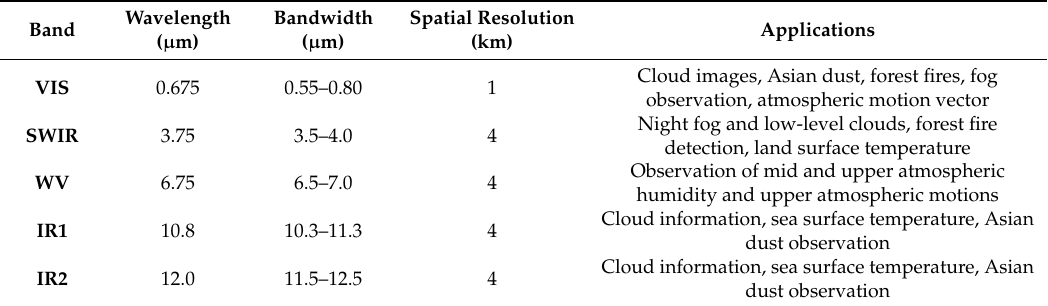
Table 1. Characteristics of bands of the Communication, Ocean, and Meteorological Satellite (COMS) Meteorological Imager (MI)